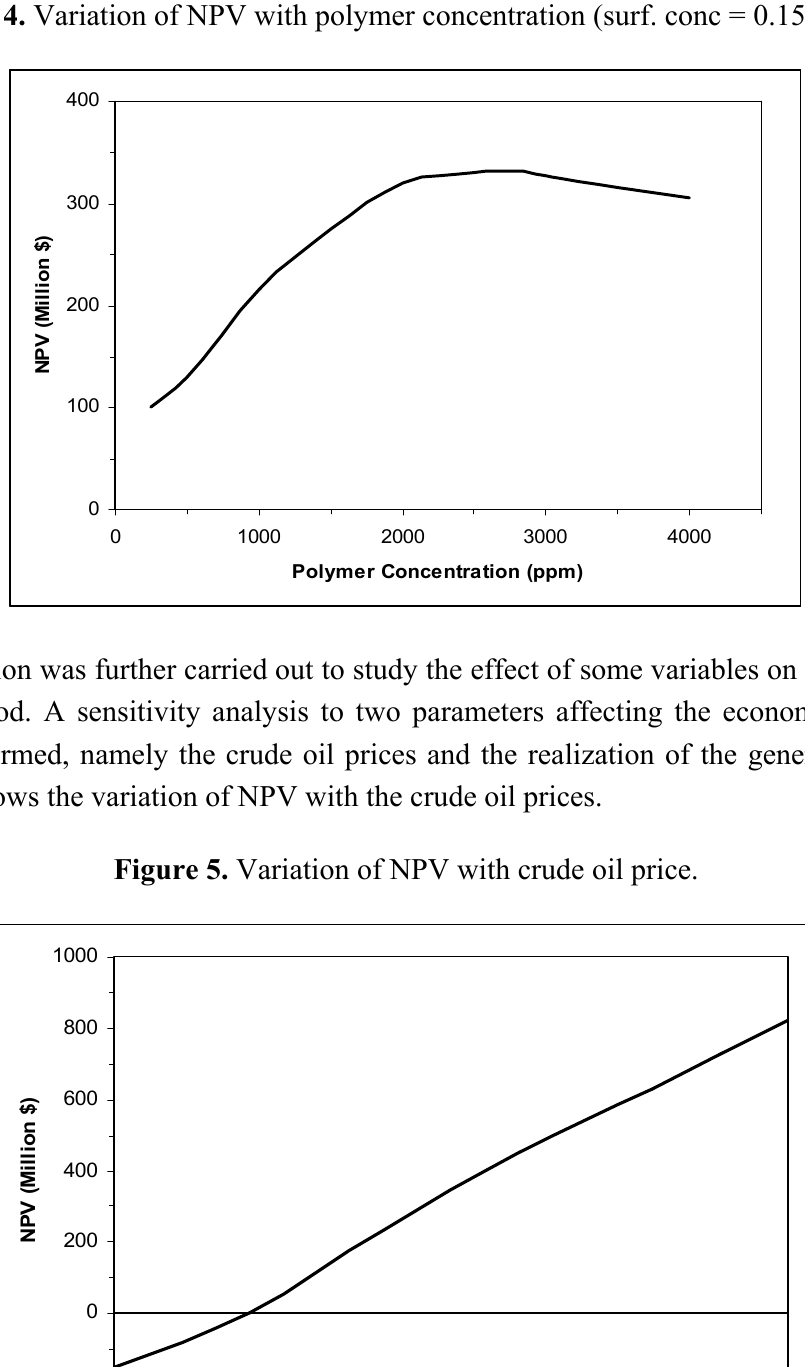
Figure 4. Variation of NPV with polymer concentration (surf. conc = 0.15 vol.%).